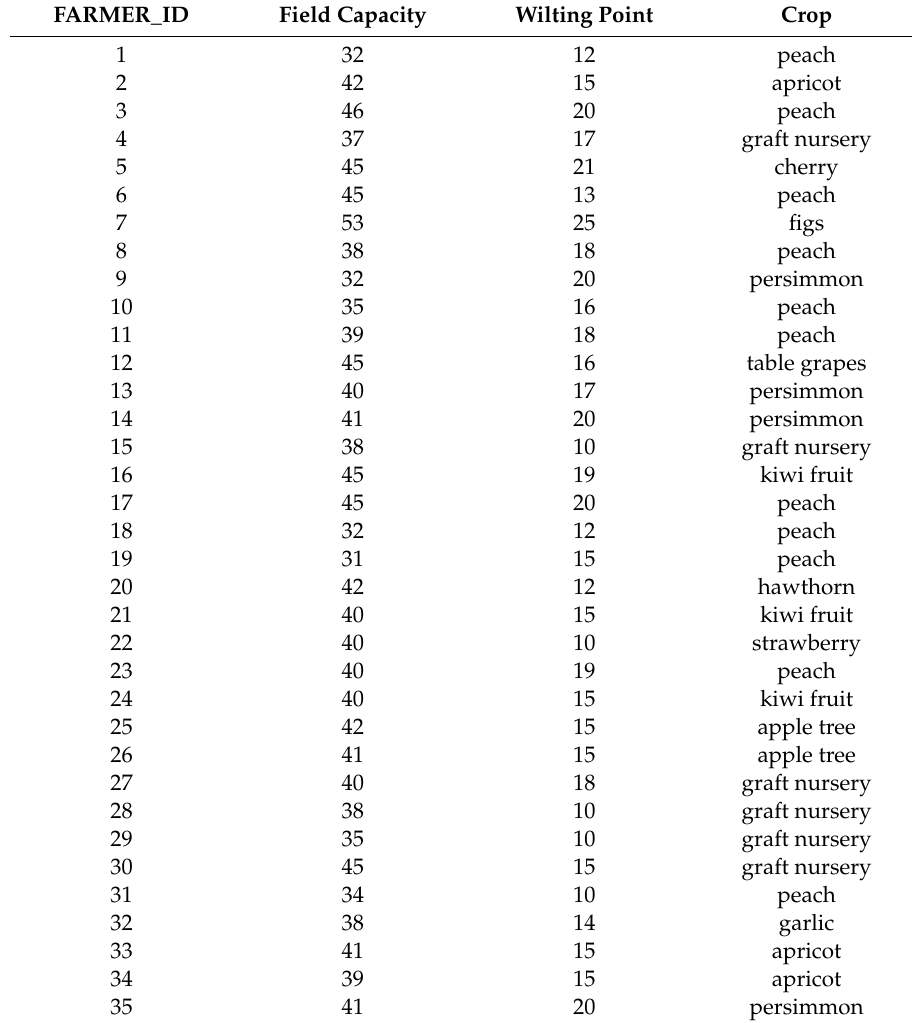
Table A3. Overview of crops and soil-water retention properties at farm